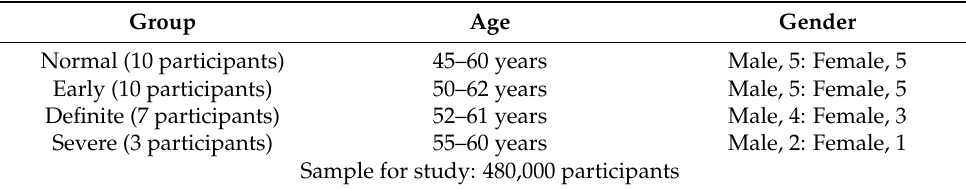
Table 1. Clinical information of the